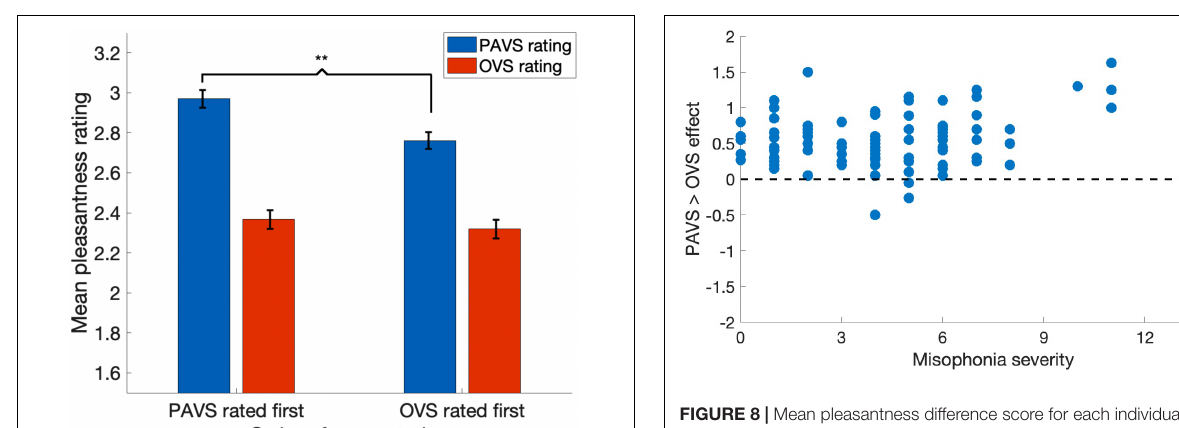
FIGURE 8 | Mean pleasantness difference score for each individual in Study 3, plotted as a function of their MQ severity score